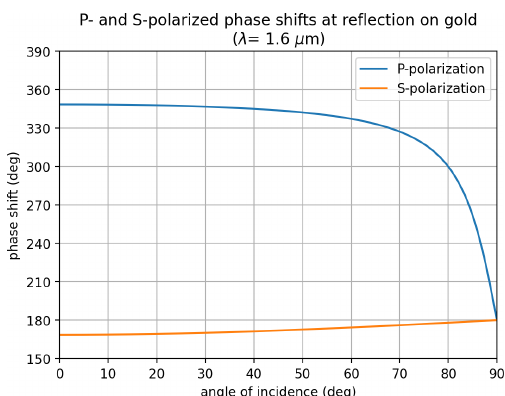
Figure 11. P-polarized and S-polarized phase shifts at reflection on gold as a function of the angle of incidence, for λ = 1 . 6µm. The 180 ◦ phase shift specific to P-pol shown in Fig. 5 is included.